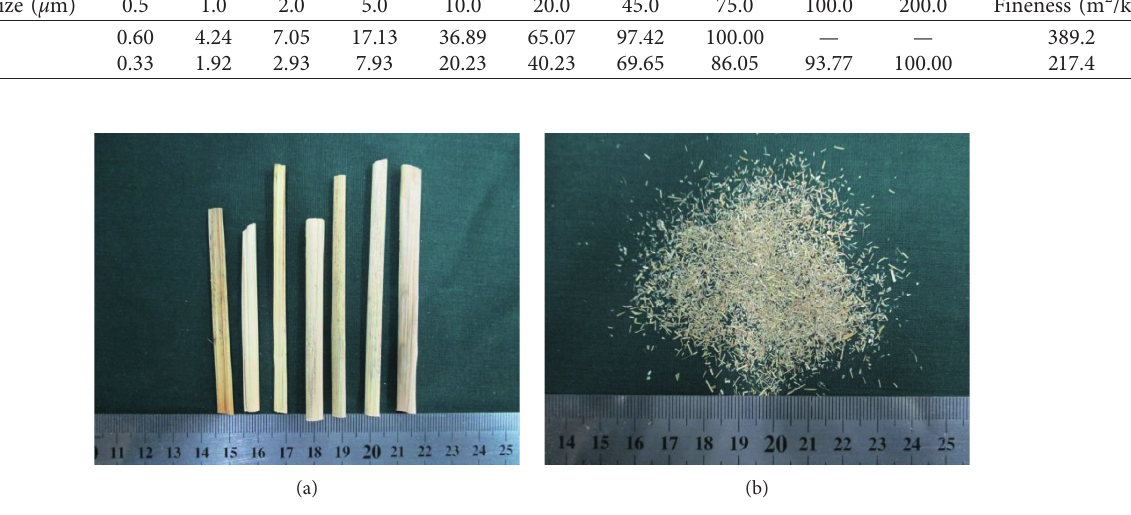
Figure 1: Appearance of straw and straw fibers: (a) straw stalk; (b) straw fibers (particle size 0.3mm). Table 3: Chemical composition of straw fibers